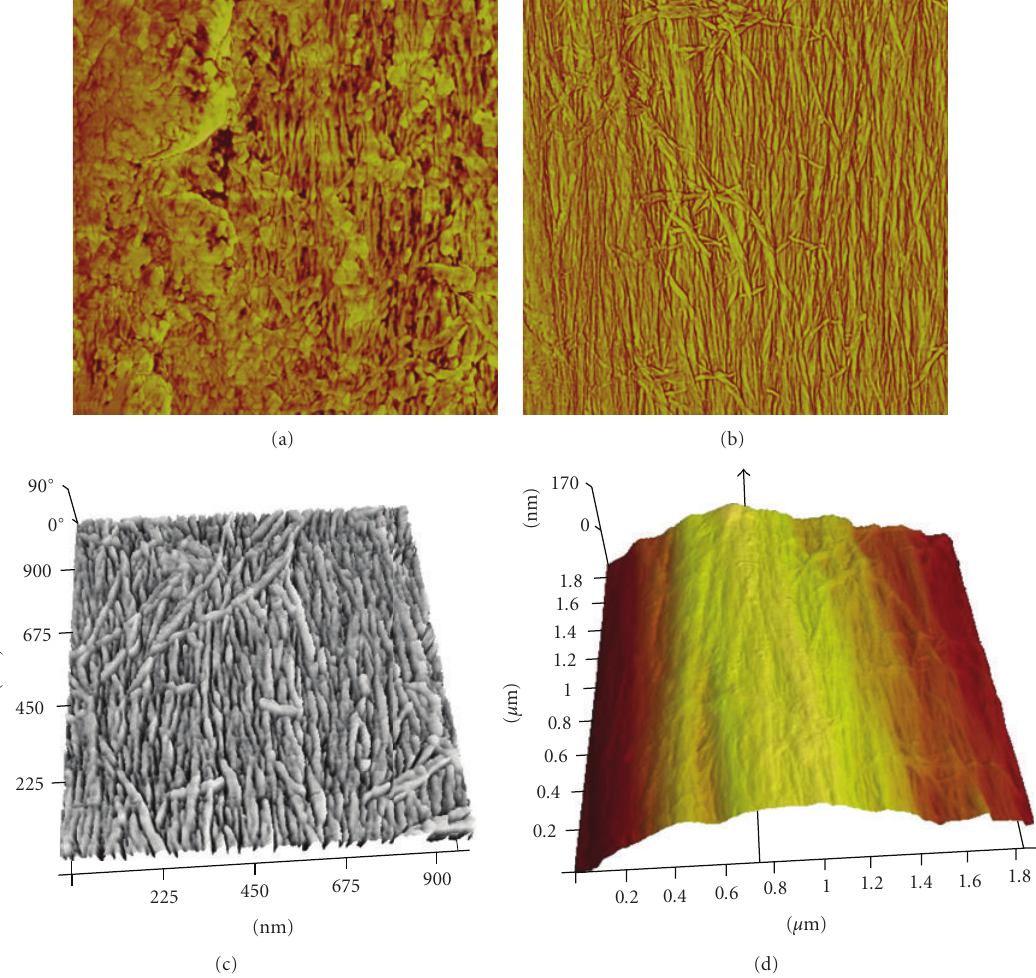
Figure 3: TM-AFM phase images (scan size of 4 μ m 2 ) of enzyme-treated fibres of (a) 5 hours, and (b) 18 hours, (c) TM-AFM 3D phase image of the microfibrils showing their preferential orientation (scan size: 1 μ m 2 ), (d) TM-AFM 3D height profile showing the main fibre axis going through the maximum height of the